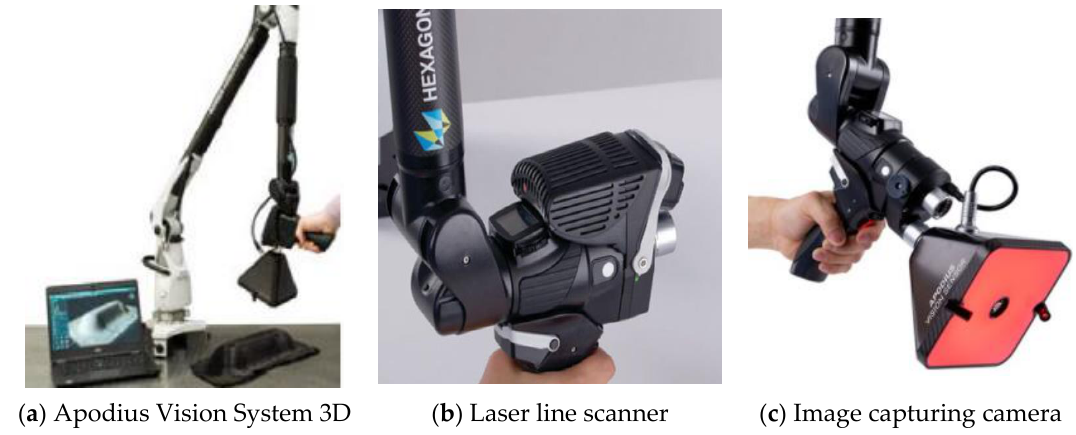
Figure 3. Apodius Vision System 3D by Hexagon ( a ) with laser scanner ( b ) and camera ( c ) [source: Hexagon] .